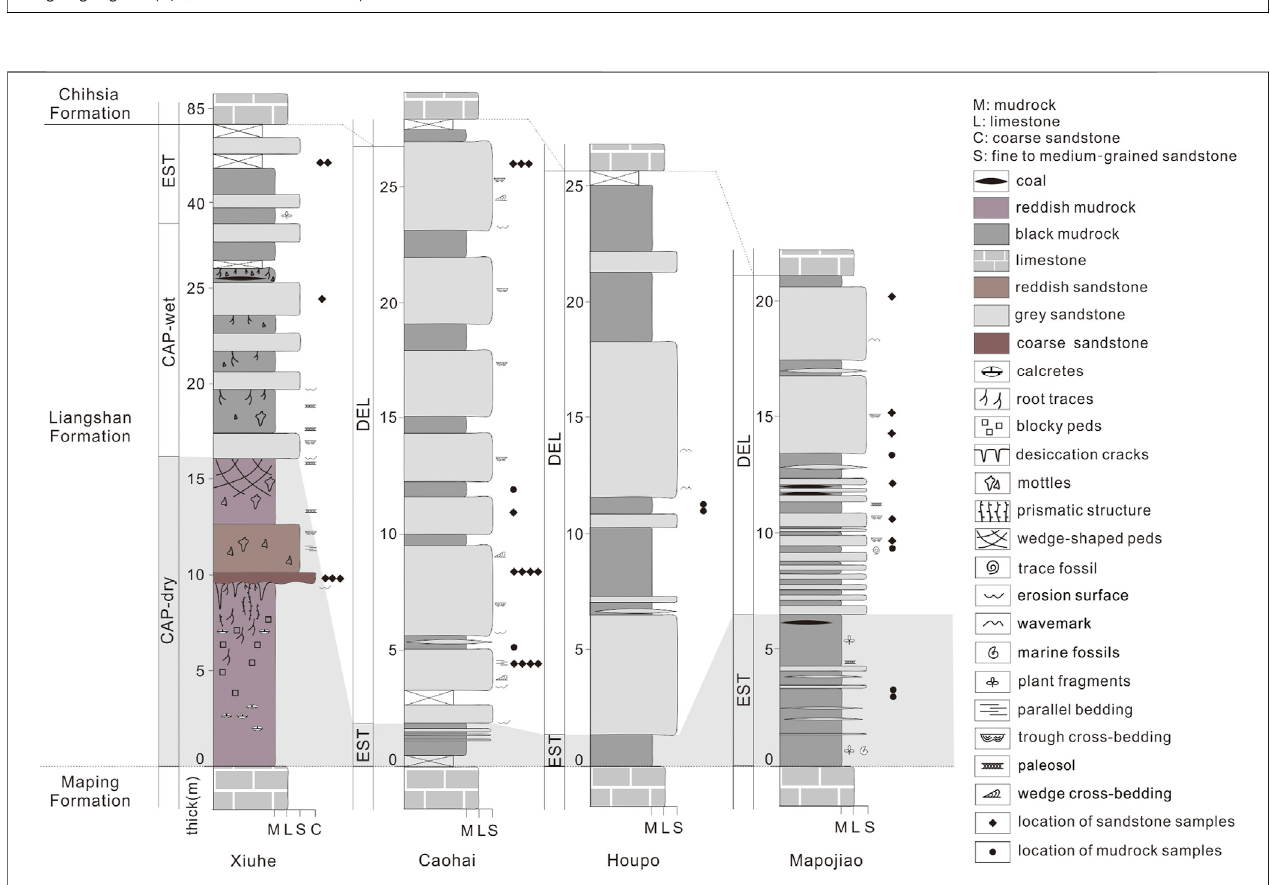
FIGURE 2 | Lithological columns of the logged successions from the top Maping through Liangshan to the basal Chihsia formations in the Xiuhe, Caohai, Houpo, and Mapojiao sections, showing the sedimentary structures of the strata, and stratigraphic positions of each sample analyzed during this study.